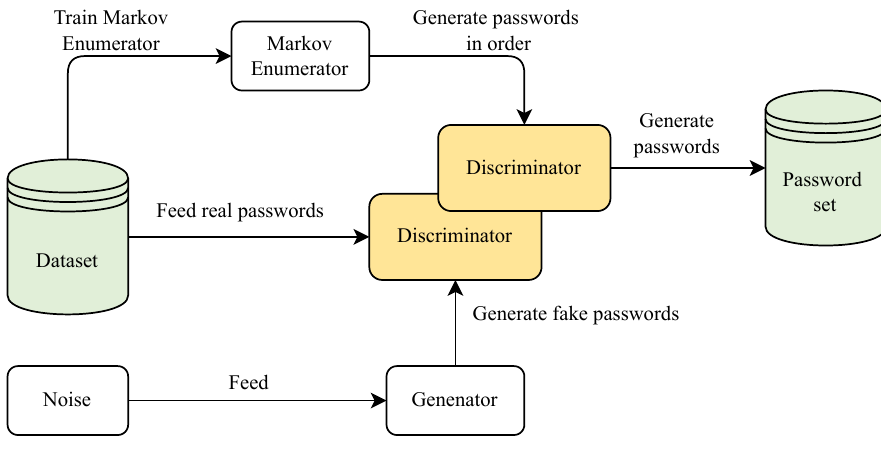
Figure 1. OMECDN